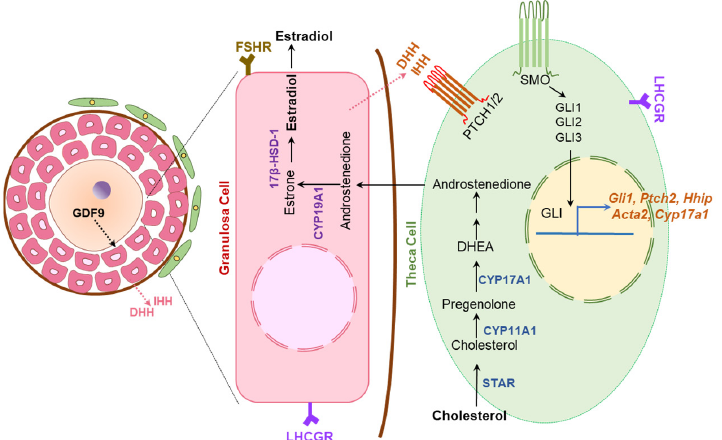
Figure 11. Hedgehog regulation of ovarian steroidogenesis. Granulosa cells (GCs) in activated ovarian follicles express DHH and IHH. The HH molecules secreted from the GCs bind the PTCH receptors expressed on theca cell (TC) precursors to induce their differentiation. Development and differentiation of TCs are essential for steroidogenesis and follicle maturation beyond early antral stage. While GDF9 expressed by oocytes act on GCs to induce DHH and IHH expression, the HH molecules are essential for TC functions. Thus, HH signaling establishes a signaling link among the germ cells and somatic cells of ovarian